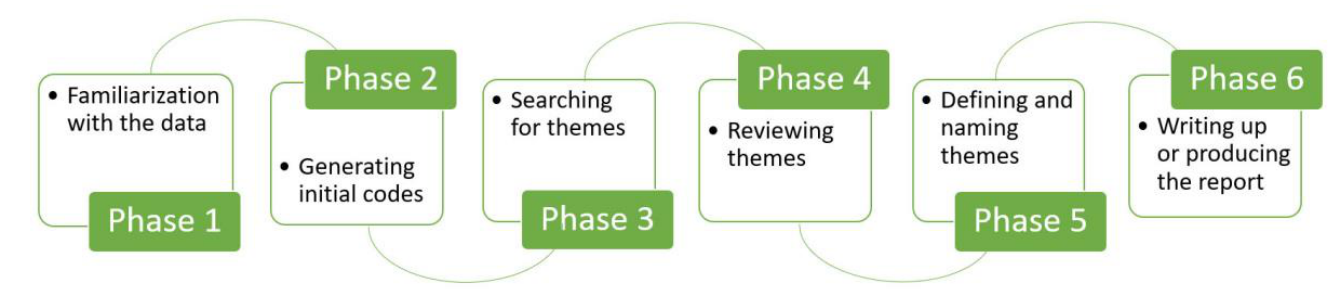
Figure 1. Phases of thematic analysis (by Clarke and Braun and Braun and Clarke [74,76]). The analysis started from the first phase, "Familiarization with the data". This process started when the authors began to notice and look for patterns of meaning and issues of potential interest in the data. Thus, collected public opinions and feedback were then read and re-read several times, i.e., the authors familiarized themselves with the empirical data by reading and revisiting the data found in public opinions and feedback. The second phase of thematic analysis, "Generating initial codes", started when the authors read and familiarized themselves with the data and, when building on the notes, generated an initial list and ideas about what was in the data and what was interesting about them. Thus, the authors coded the relevant data, seeking to find initial codes. The third analysis phase named by Clarke and Braun [76], "Searching for themes", allowed the authors to re-focus the analysis at the broader level of themes, rather than codes, involved revisiting all relevant data that are similar to certain codes to form the initial themes, i.e., trying to combine different codes that may have been very similar or may have been considered the same aspect within the data. During the fourth phase of thematic analysis, "Reviewing themes", the authors crosschecked the chosen themes, trying to cohere the data within themes together meaningfully, while finding clear and identifiable distinctions between themes. At the end of this phase authors found the clear idea of the various themes and how they could fit together. During the fifth phase, "Defining and naming themes", the authors clearly defined the themes and named them, trying to give the reader a sense of what the theme was about. As the goal of this phase was to be able to "clearly define what your themes are and what they are not" [74], in seeking this goal, the authors focused on defining each theme, trying to identify the essence of the themes. Therefore, the authors constructed fulfilled themes, explaining their meaning and defining each theme, which should reflect the overall story of the research topic. During the sixth phase, "Writing up